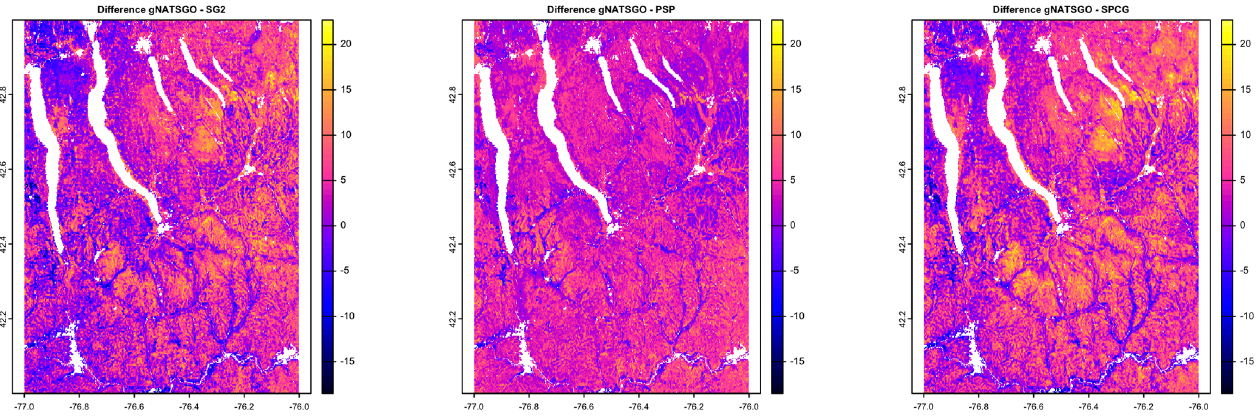
https://doi.org/10.5194/soil-8-559-2022 SOIL, 8, 559–586,